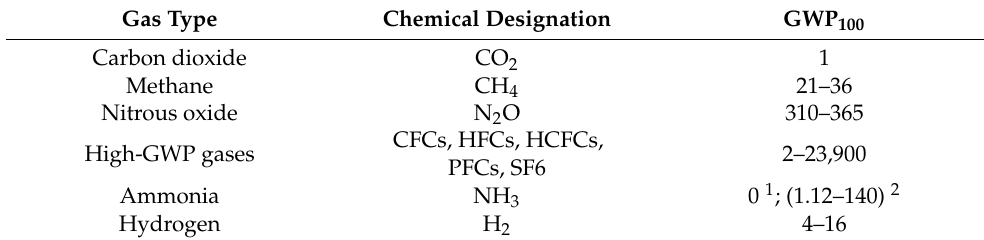
Table 2. Global Warming Potential indicators for the 100-year horizon